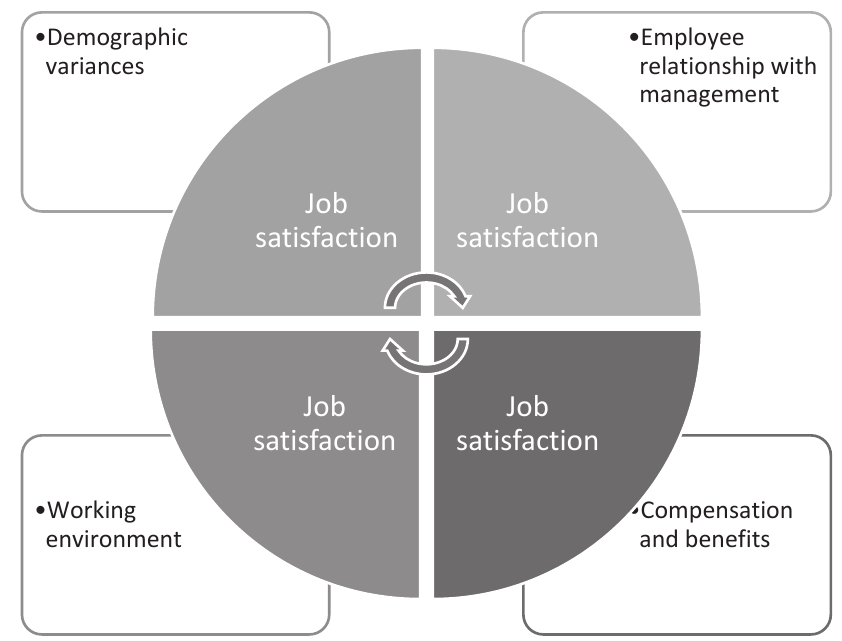
Figure 1. The four predictors of independent variables to job